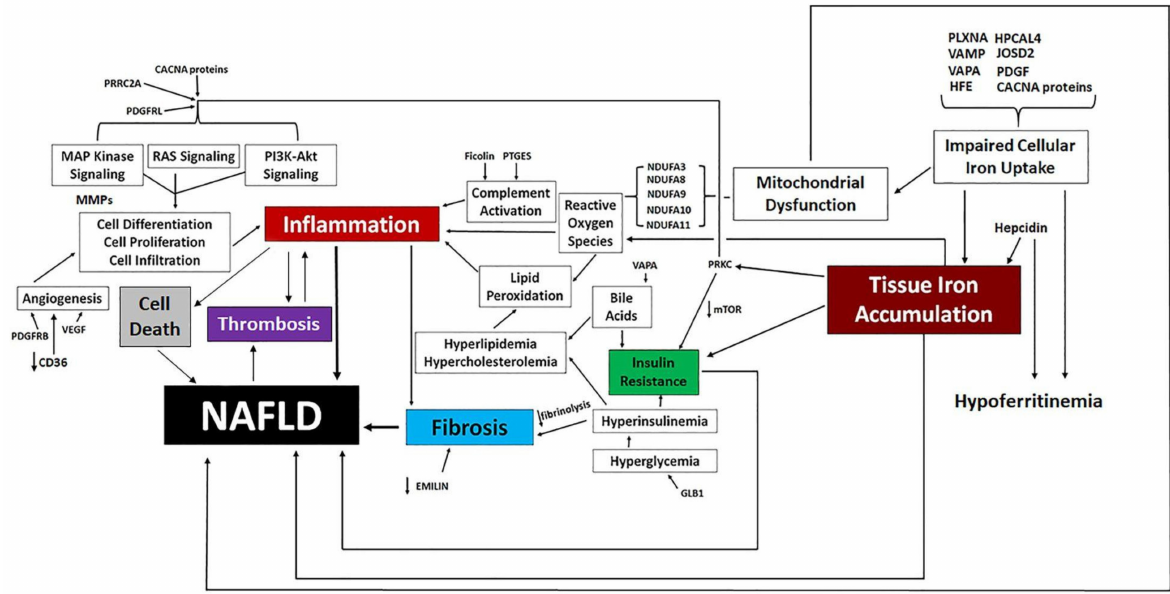
Figure 7. Proposed Molecular Mechanisms Underlying the Clinical Development of AA-Induced